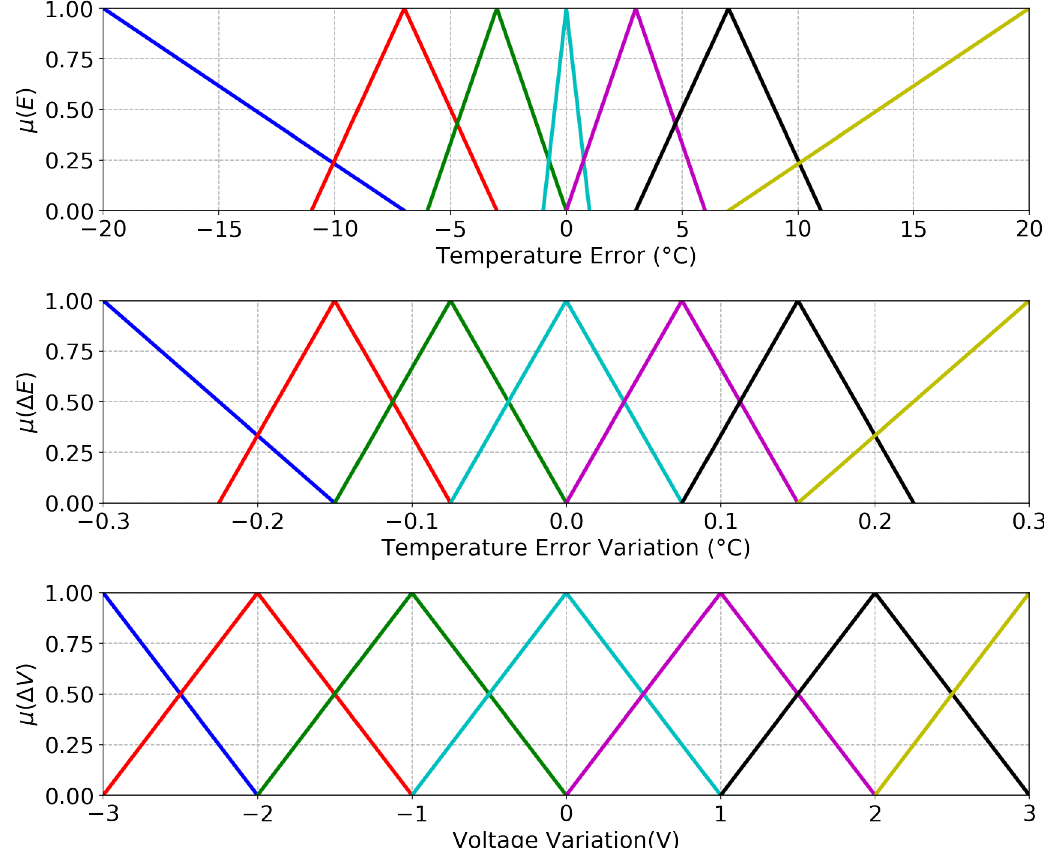
Figure 5. Membership functions. Negative big (blue line), medium (red line), small (green line), zero (cyan line), positive small (purple line), medium (Black), big